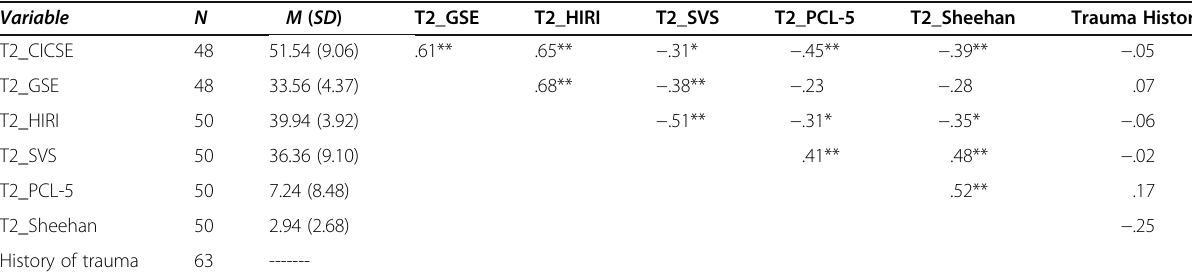
Table 8 Correlations between key study variables at time 2